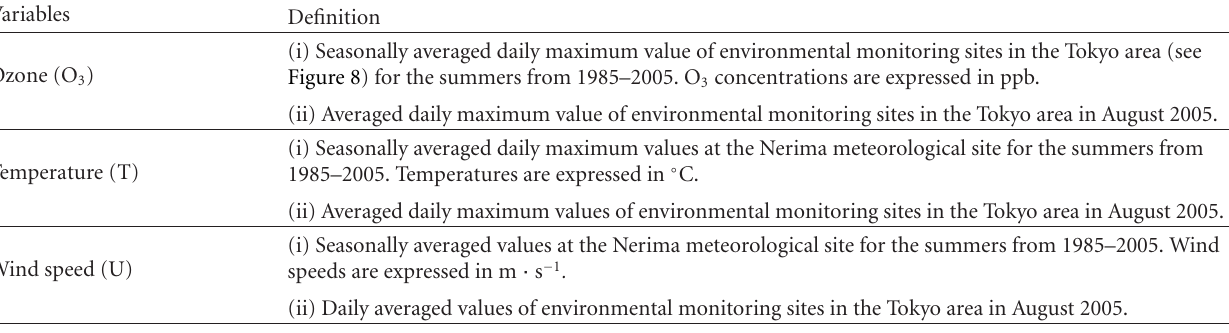
Table 1: Variables used in the regression analysis.